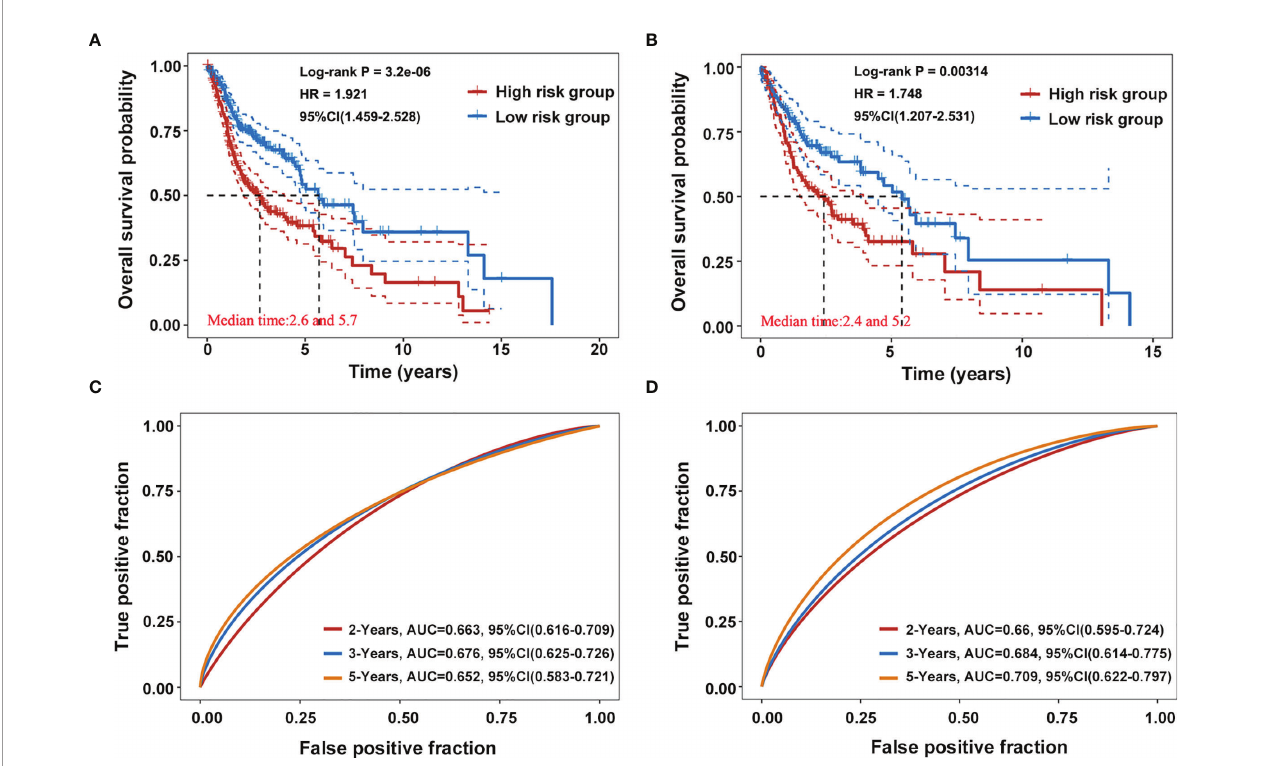
FIGURE 3 | Validation of the prognostic capacity of the selected four-AG signature. (A, B) Kaplan – Meier survival curves for the risk model based on the training cohort (the whole dataset, n = 502) and the testing cohort (randomly selected, n = 250). (C, D) Receiver operating characteristic (ROC) curves for the risk model in the training and testing